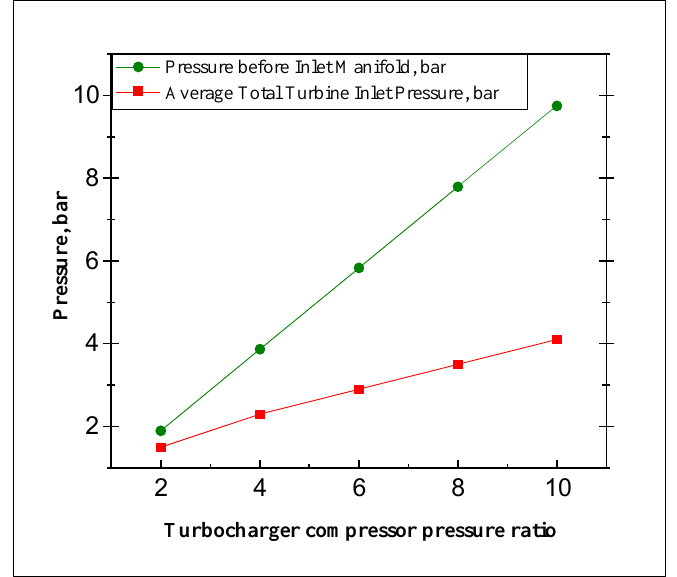
Figure 5. Pressure of the turbocharger before the manifold and the average total turbine